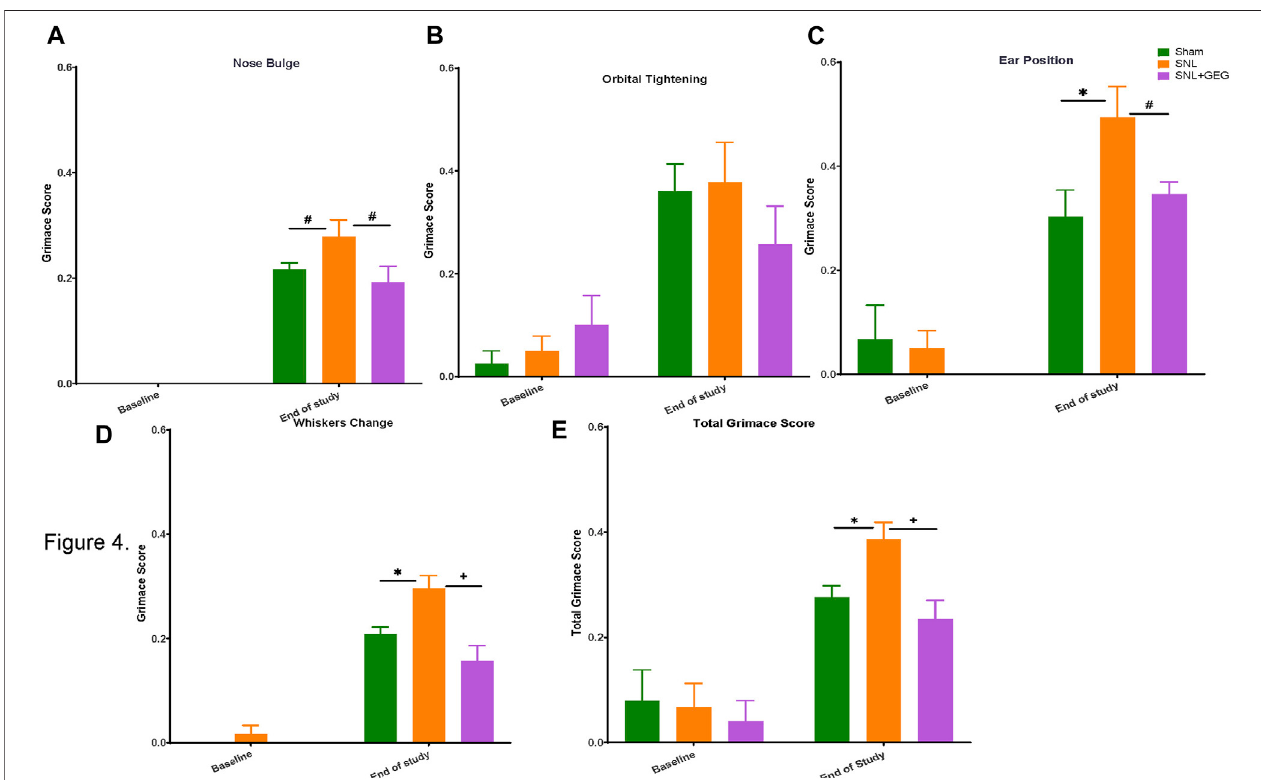
FIGURE 4 | Effect of GEG supplementation on spontaneous pain in SNL rats as assessed by the rodent grimace test, showing scores for nose bulge (A) , orbital tightening (B) ,earposition (C) ,andwhiskerchange (D) ;total (E) .Dataisexpressedasmean±SEM. n =5 – 6pergroup.Datawasanalyzedbyone-wayANOVAfollowed by a post hoc Tukey ’ s test at each collection time. * p < 0.05 vs Sham. # 0.05 < p < 0.1 vs Sham or vs SNL. + p < 0.05 vs SNL.